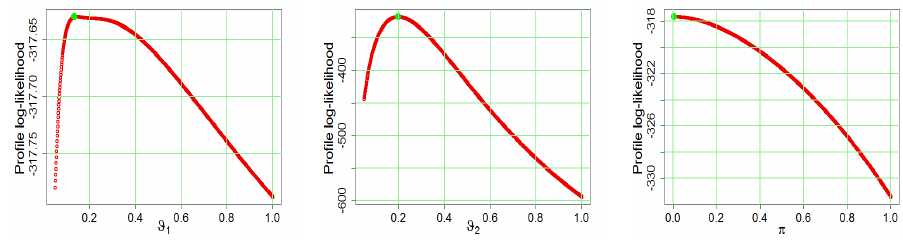
Fig. 18. The PLLF for for Dataset I Figure 18. The PLLF for for Dataset